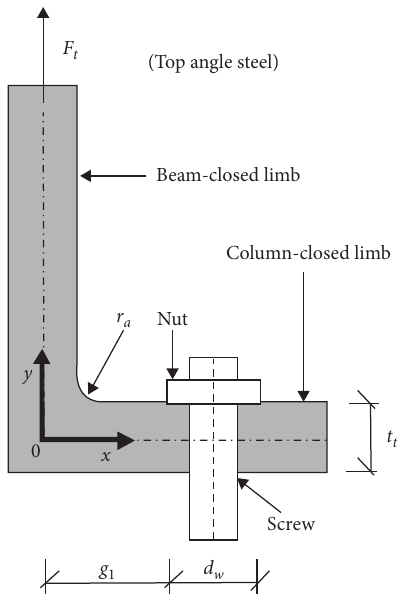
Figure 16: Computational schematic diagram (units: mm).